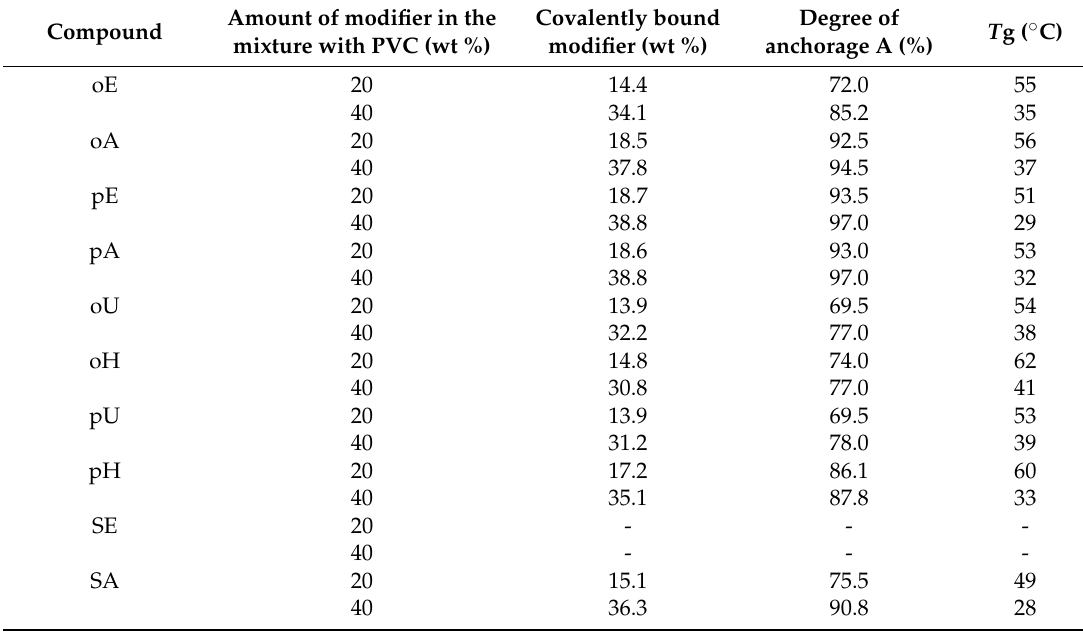
Table 1. Results for the anchoring reaction of modifiers to PVC ( T g of unmodified PVC: 85 ˝